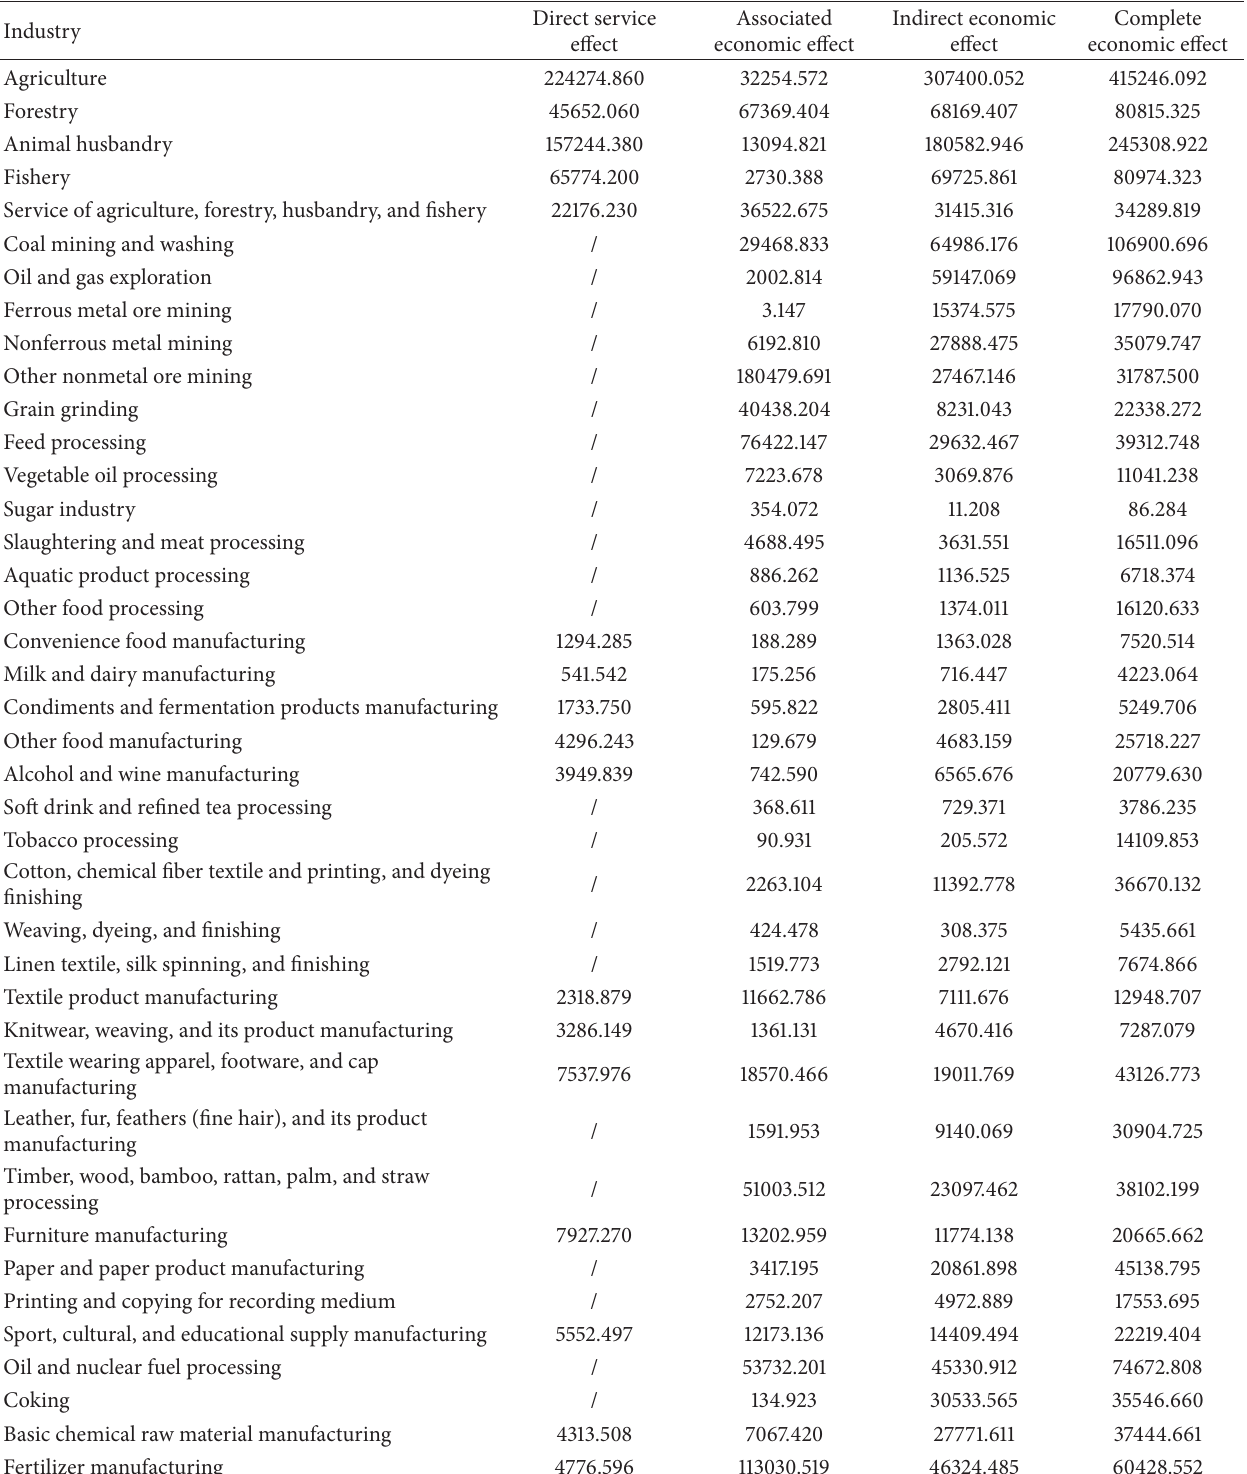
Table 3: Results of economic effects (measuring unit: ten thousand